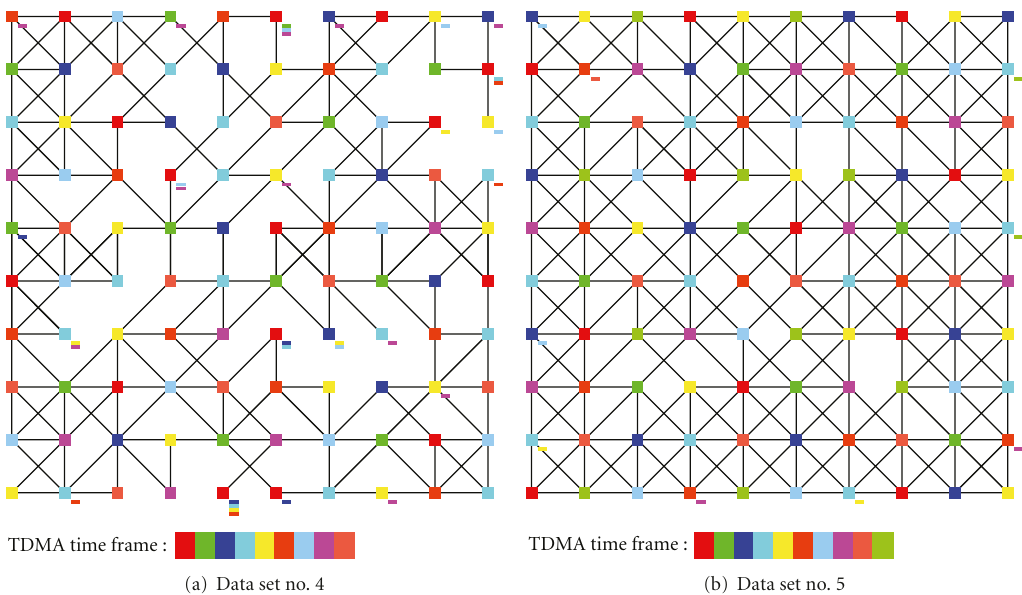
Figure 2: The broadcast scheduling of two data sets in Table 1 with our ILS algorithm.